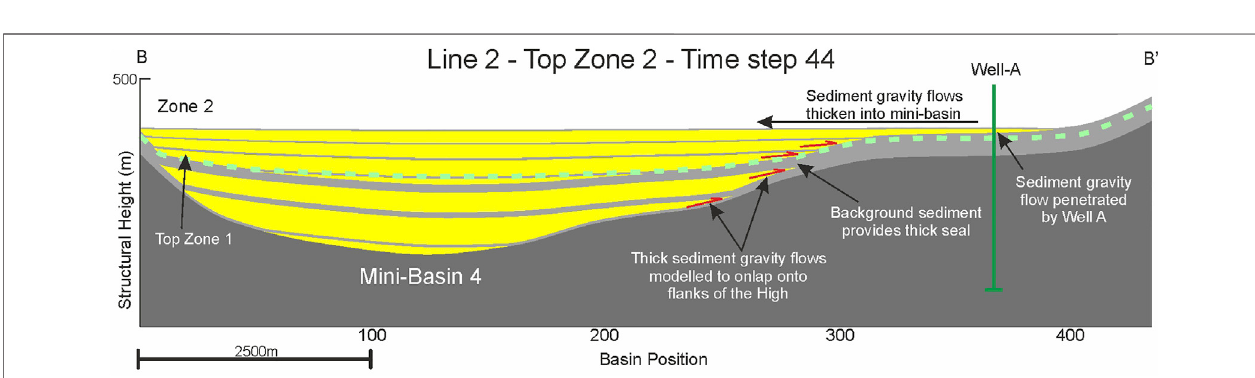
FIGURE 12 | Time-Step 44 (10.0 Ma) of Line 2, showing the predicted presence of sediment gravity fl ows in Minibasin-1. Thick sediment gravity fl ows modelled in Zone 1 onlap onto the high fl anks, topped by a thick laterally extensive seal of draping mudstone. Thin unit penetrated by Well-A in Zone 2 would likely have a thicker, lateral equivalent found within the basin which is what the Onlapse-2D model has simulated to develop.